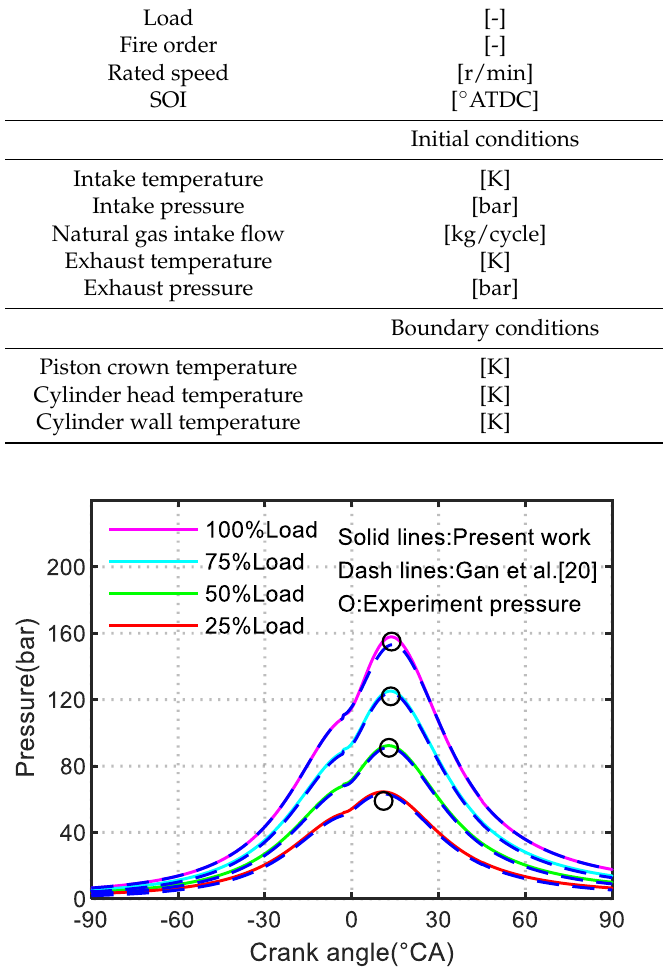
Figure 6. Cylinder gas pressure.